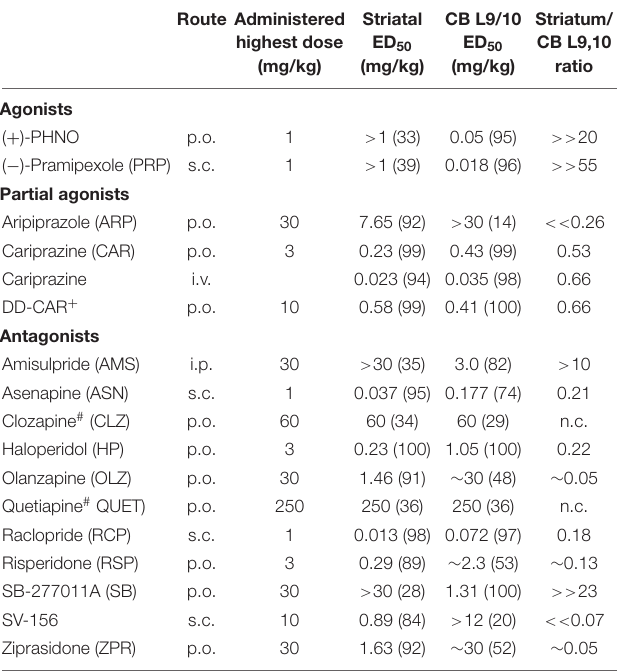
TABLE 2 | Effects of selected antipsychotics, D 3 R agonists, antagonists, on the [ 3 H]( + )-PHNO uptake in rat striatum and cerebellum L9,10 region* , &